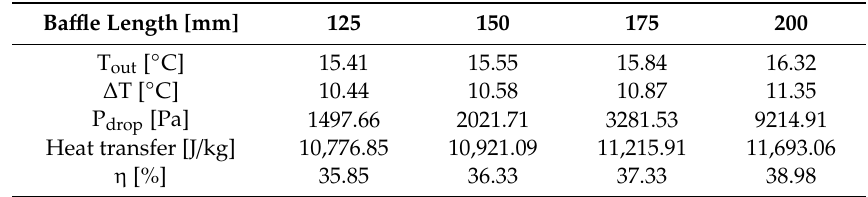
Figure 9. Baffle slope and length effect on temperature contours